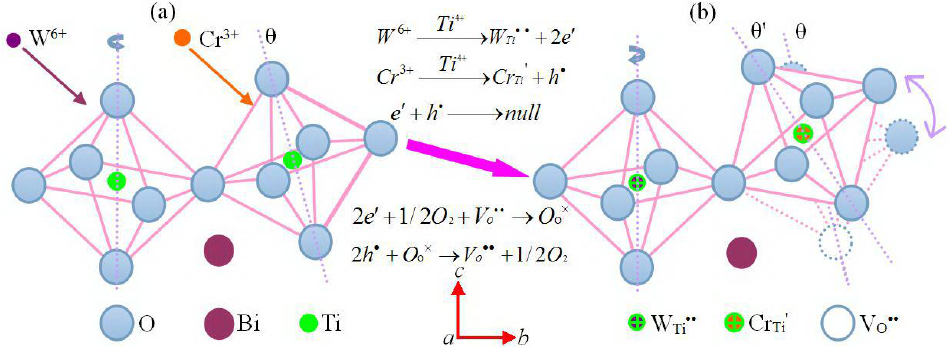
Figure 5. Status change of oxygen octahedron in Bi 4 Ti 3 O 12 structure, ( a ) before W/Cr co-doping; ( b ) after W/Cr co-doping.